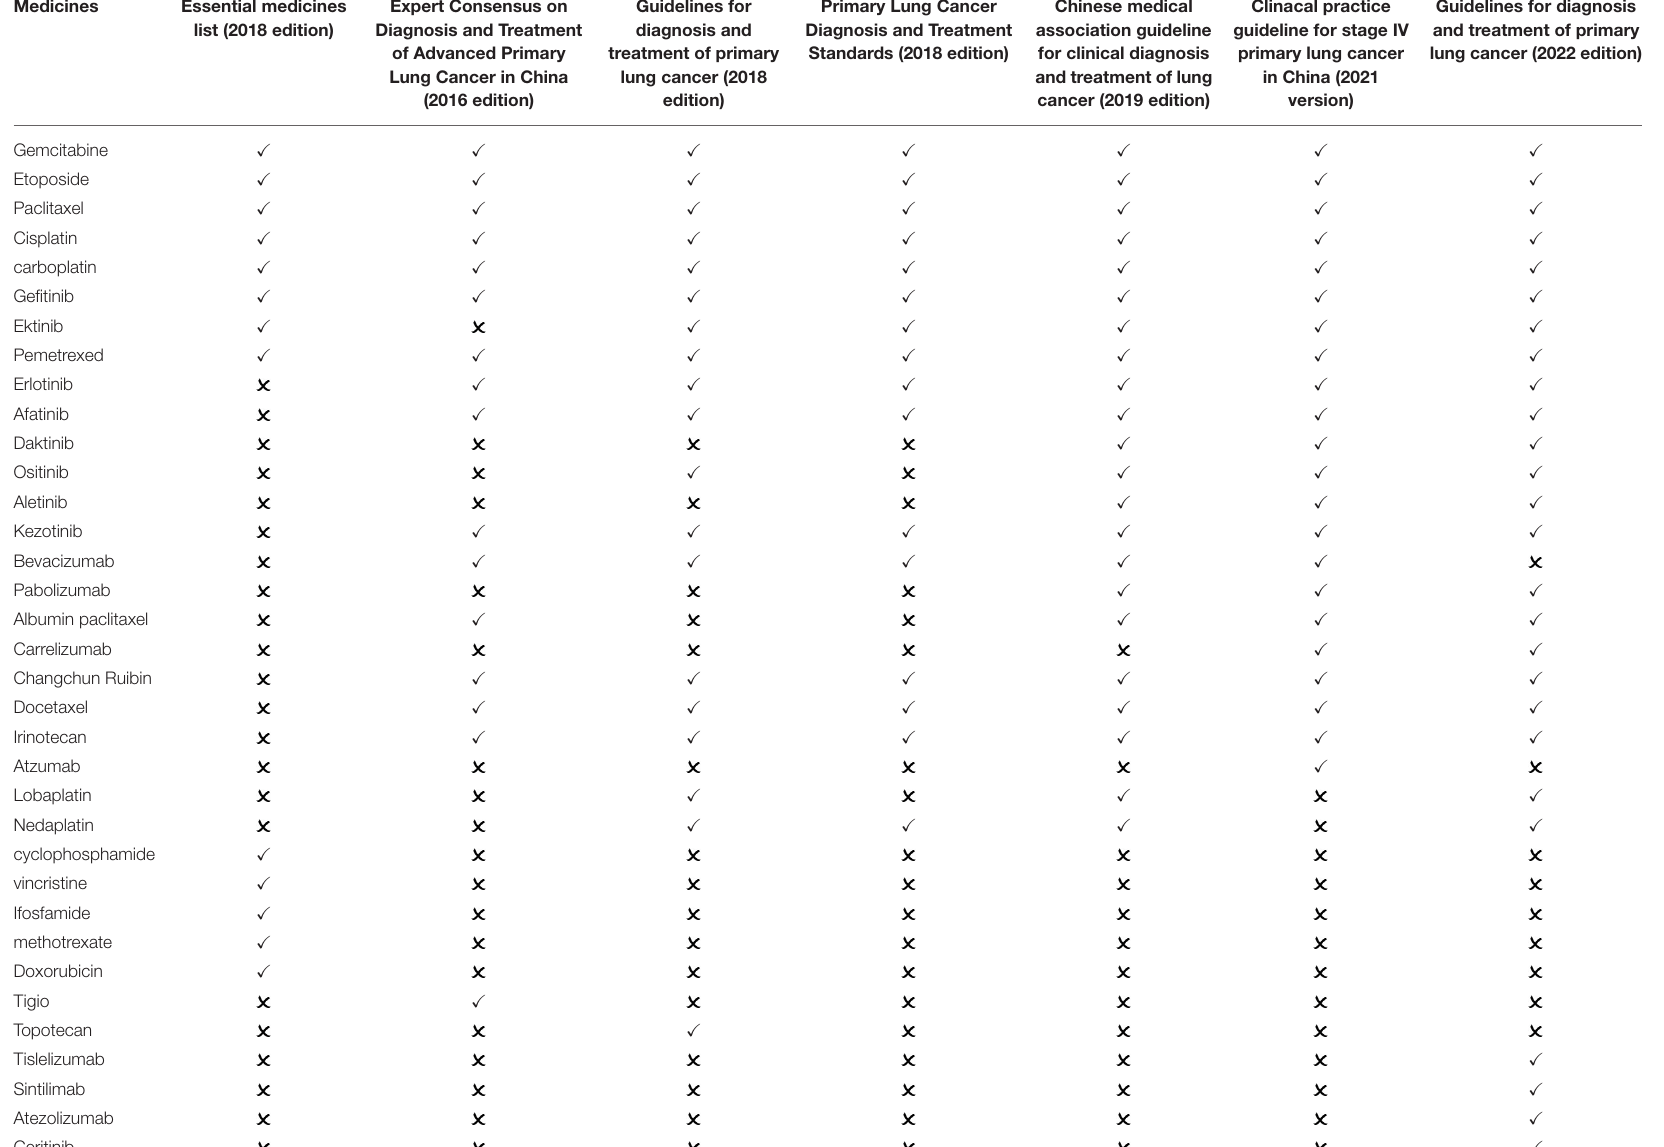
TABLE 4 | Medicines in the list and guidelines for the treatment of lung cancer.